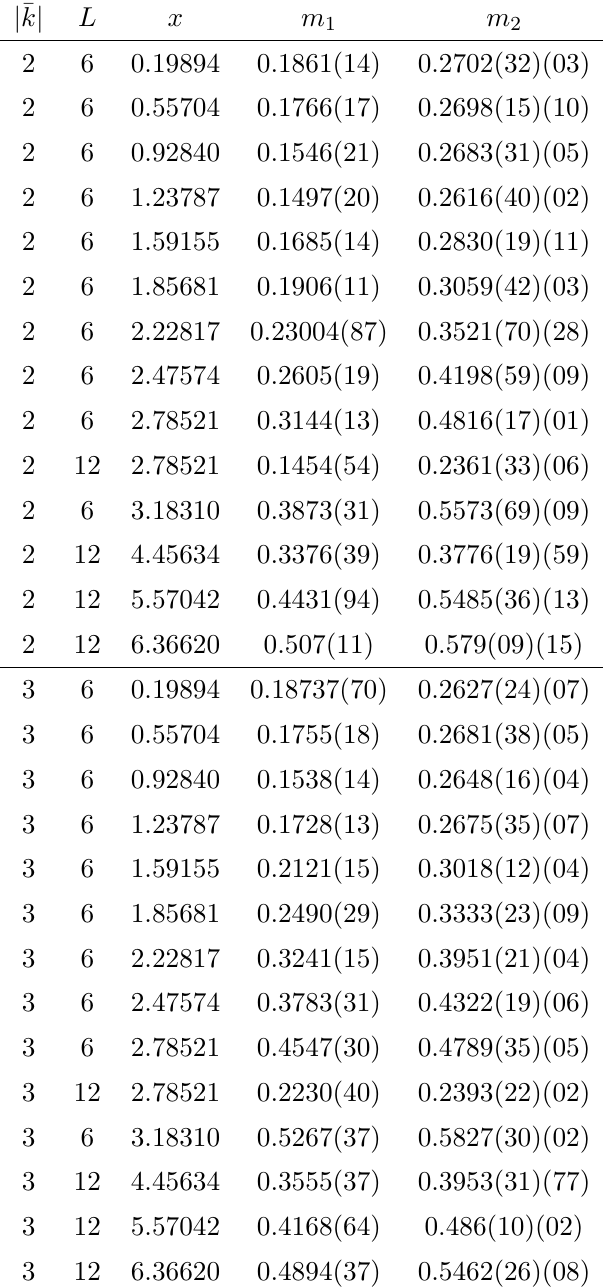
Table 22. Mass gap and next excited state energy (in lattice units) in the zero-electric (cid:13)ux scalar sector for SU(11) (continued).